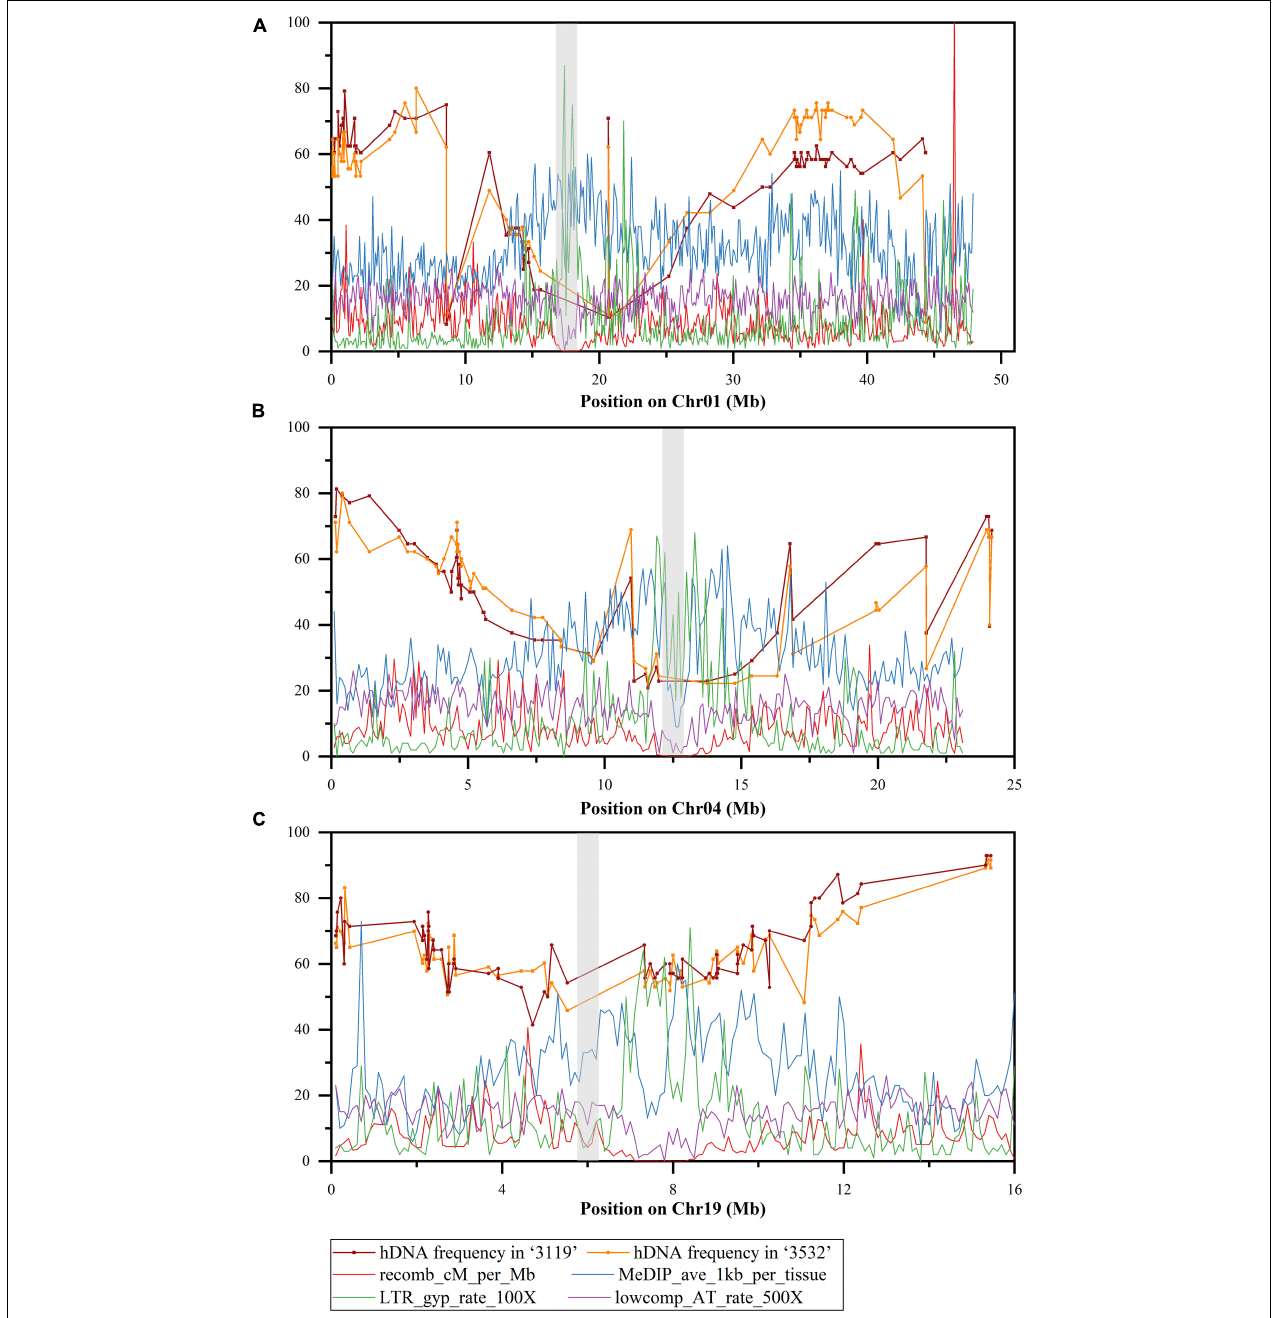
FIGURE 4 | hDNA frequency (%) on Chr01, 04, and 19 under multiple markers detected (the gray boxes indicate the putative centromere region). (A) Chromosome 1, (B) chromosome 4, and (C) chromosome 19, recomb_cM_per_Mb indicates recombination rates estimated from linkage disequilibrium (LD); MeDIP_ave_1kb_per_tissue indicates methylation rates as measured by the number of methylated DNA immunoprecipitation (MeDIP) reads per kilobase of target sequence per million reads mapped, long terminal repeat (LTR)_gyp_rate_100 × indicates the proportion of bases in LTR Gypsy retrotransposons (multiplied by 100 to equalize scales), and lowcomp_AT_rate_500 × indicates the proportion of bases in A-, T-, or AT-rich low-complexity sequences (multiplied by 500 to equalize scales).